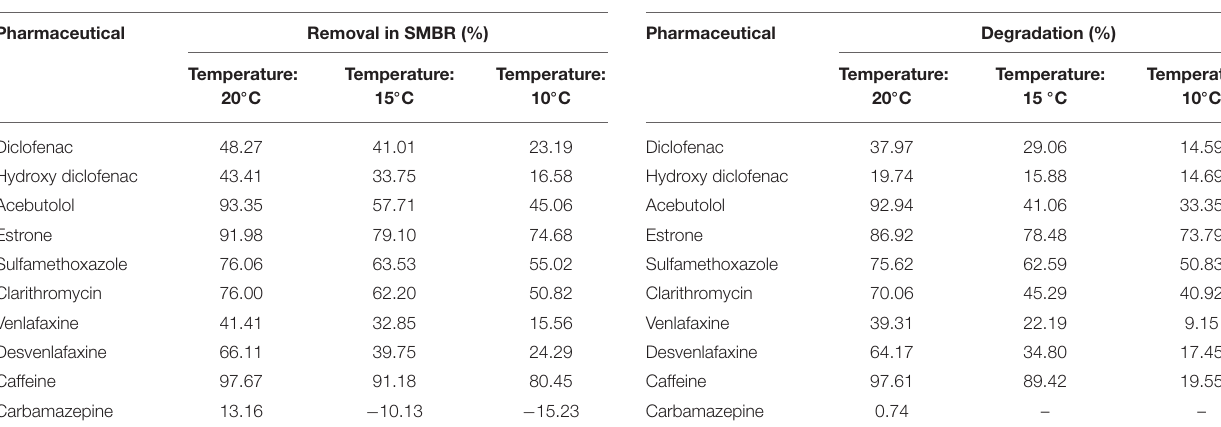
TABLE 4 | Degradation (%) of pharmaceuticals in SMBR at varying operating